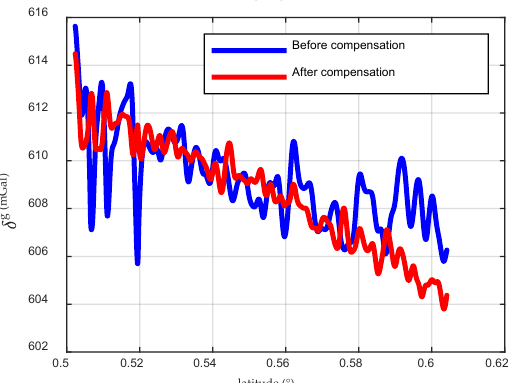
Figure 8. Gravity-measurement results for survey line SHNS2 before and after compensation.